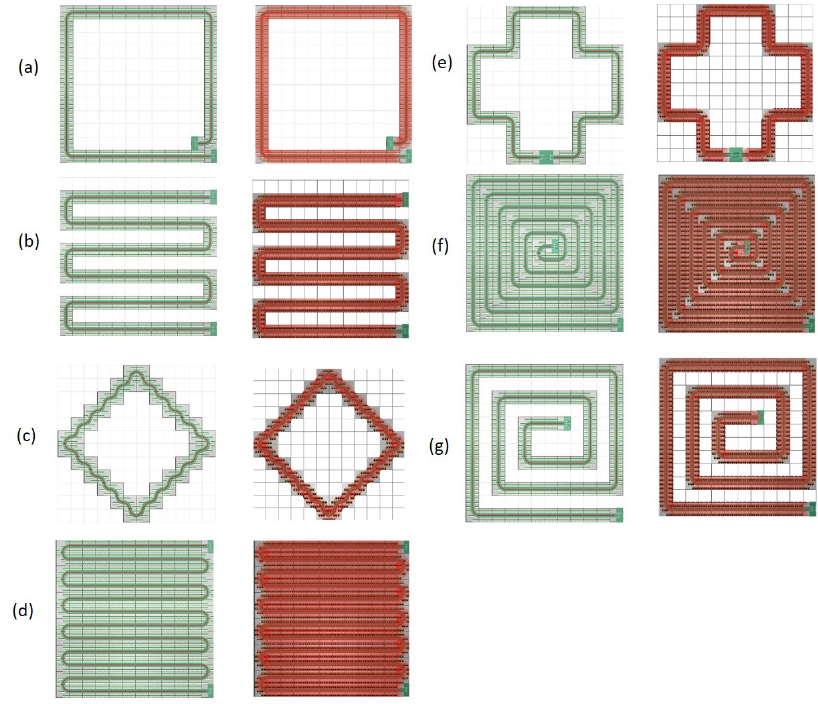
Figure 13. The test cases used for analysing the key features of the proposed design framework by using different test track layouts. The details of the test cases ( a – g ) are given in Table 1. The robot reachability of each case is overlaid in shaded color. The reachability was 100% for all the